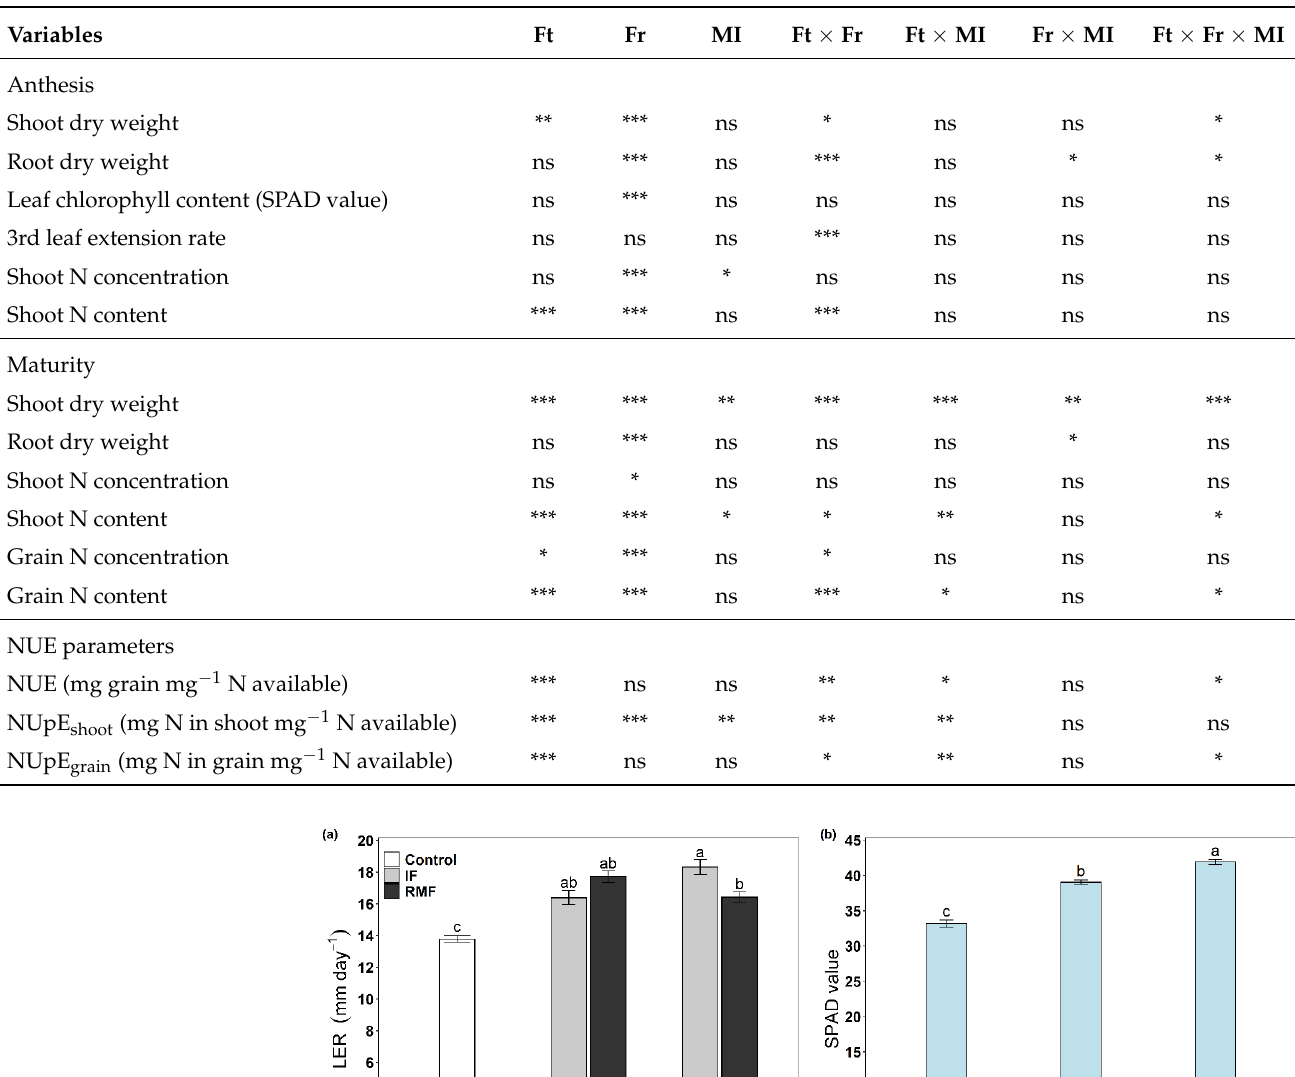
Table 1. Analysis of variance (ANOVA) summary for wheat growth, N concentration and NUE parameters as influenced by fertiliser type (Ft), fertiliser rate (Fr), microbial inoculant (MI) and their interactions at anthesis and maturity. *, ** and *** denote significance at p ≤ 0.05, 0.01 and 0.001, respectively; ns, non-significant at p > 0.05.